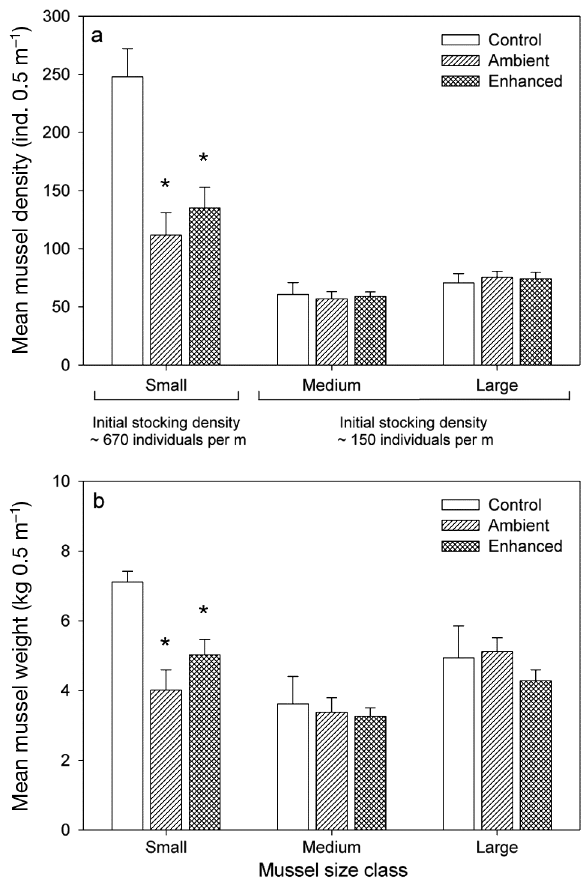
Fig. 3. Perna canaliculus . (a) Mean density and (b) mean combined weight (+SE, n = 10 for ambient and enhanced treatments, and n = 5 for controls, except for large size class with ambient treatment: n = 8, and large size class with con- trol treatment: n = 4) of P. canaliculus present per 0.5 m sec- tion of line for 3 size classes (small: 20−40 mm shell length at deployment, medium: 40−60 mm, and large: 60−70 mm) and 3 fouling treatments (controls, ambient fouling, and en- hanced Didemnum vexillum fouling). Initial stocking densi- ties of the size classes per metre of experimental line are in- dicated. " Significant fouling treatment effects (within mussel size class) in relation to control lines as indicated by pairwise comparisons ( t -statistic, p <